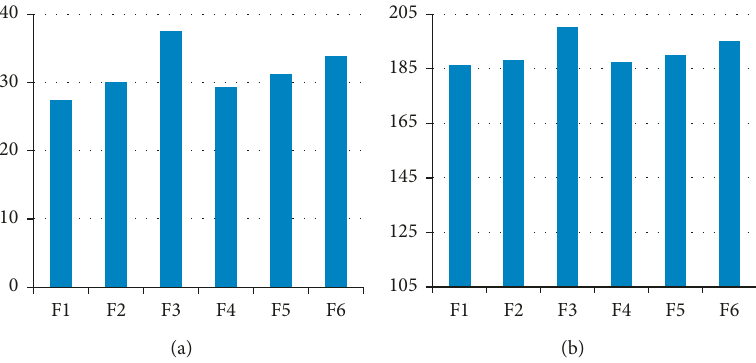
Figure 4: Shoot (mg/plant) (a) and root (mg/plant) (b) dry matter of the soybean seedlings 7days after